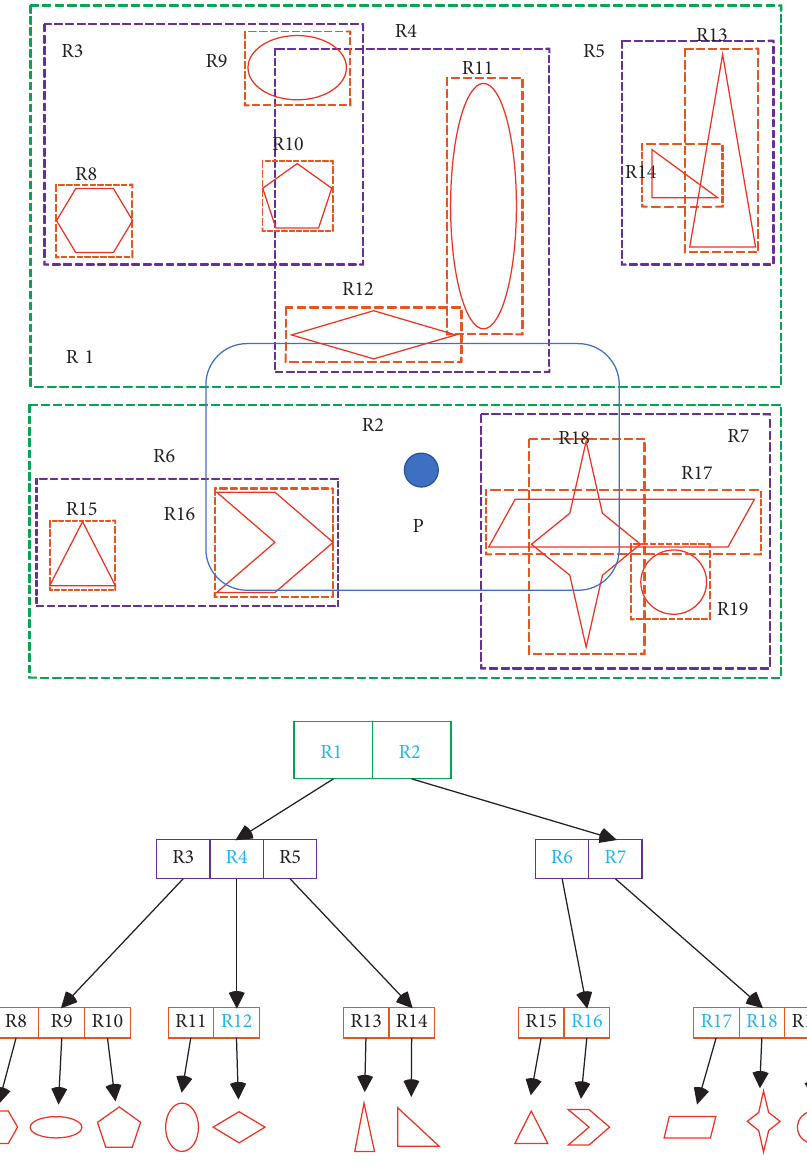
Figure 2: Schematic diagram of the R tree structure